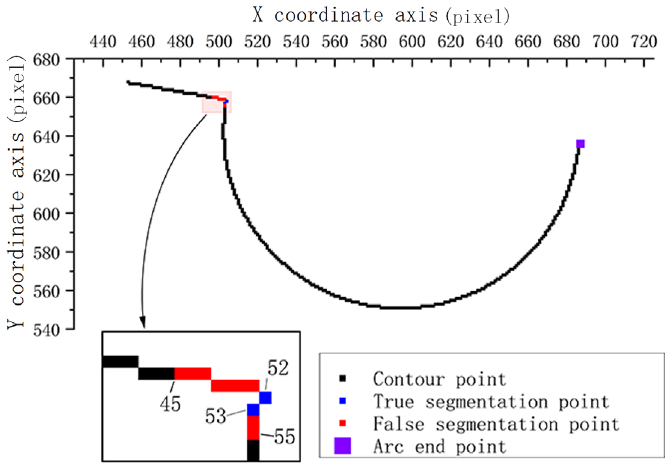
Figure 14. Arc of l Figure 14. Arc of .